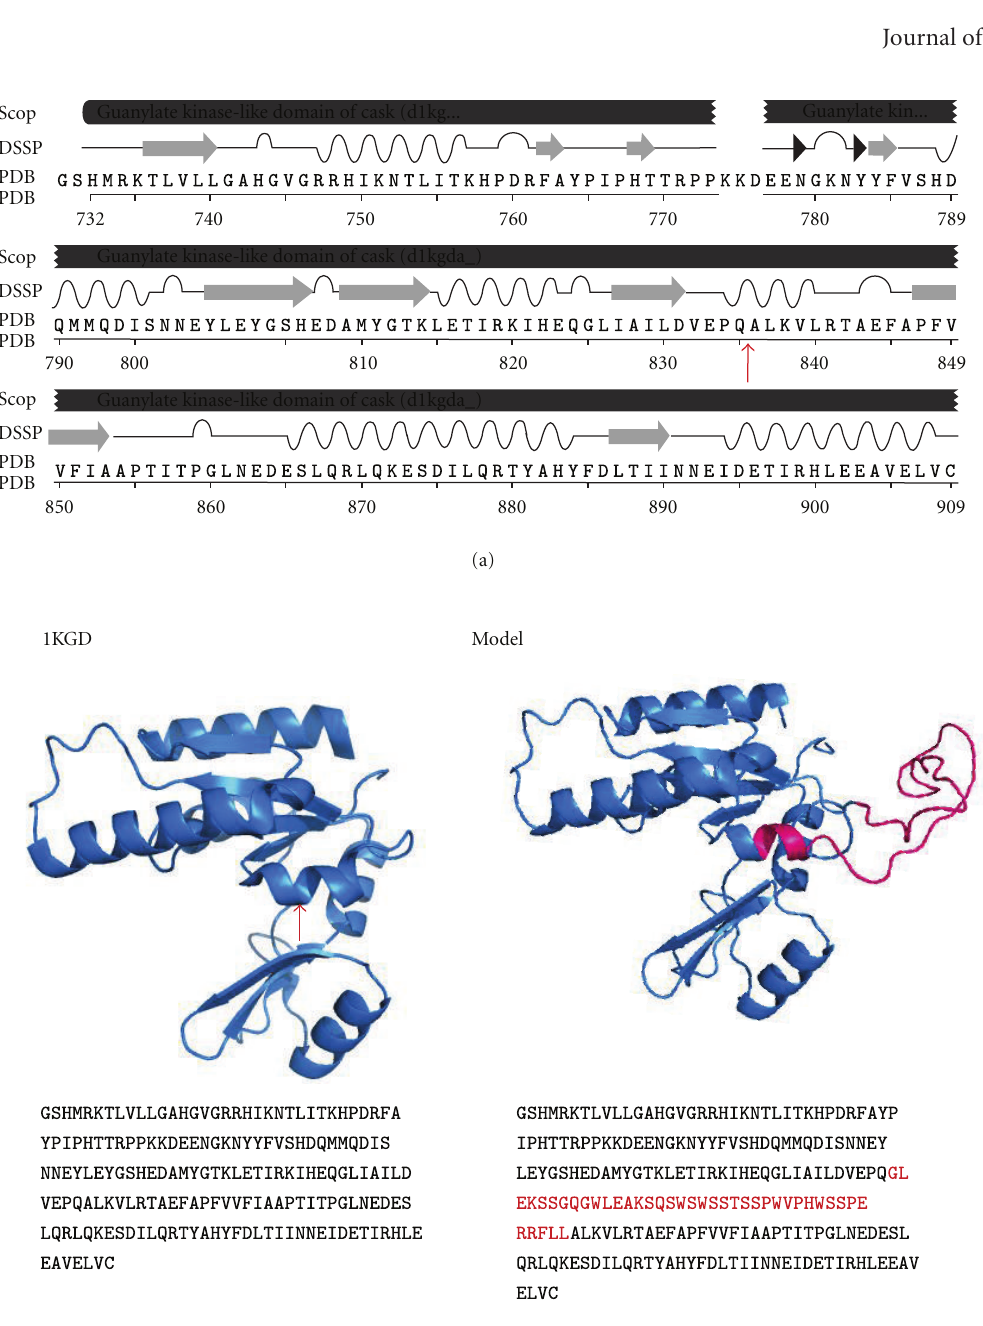
Figure 7: E24a codes for a peptide insertion in the guanylate kinase domain of the CASK polypeptide. (a) Sequence of human guanylate kinase domain according to pdb structure, 1KGD, with secondary structure elements indicated as follows: arrows, beta strands; coils, alpha helices. Position of E24a-encoded peptide insertion is between residues Q835 and A836 (vertical arrow). (b) PyMOL representation of guanylate kinase domain from pdb structure, 1KGD [31]. Secondary structure elements are shown as in (a). The position of the E24a peptide insertion is indicated (vertical arrow). (c) The E24a peptide insertion was threaded onto the CASK guanylate kinase-like domain (1KGD) using MUSTER [32]. The E24a insertion is shown in